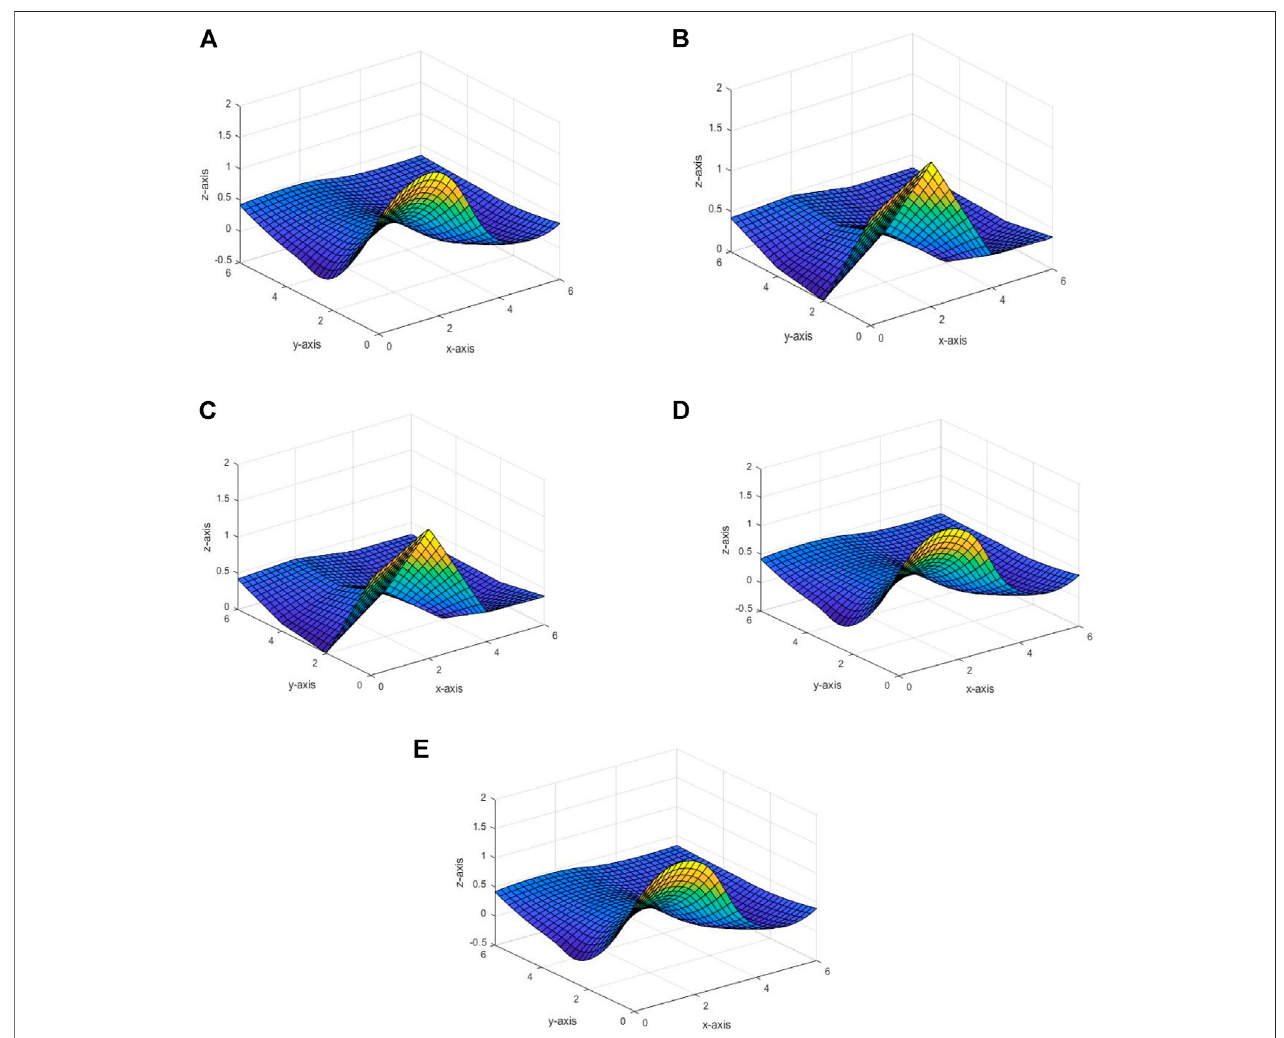
FIGURE 2 | Local control of surface interpolation.